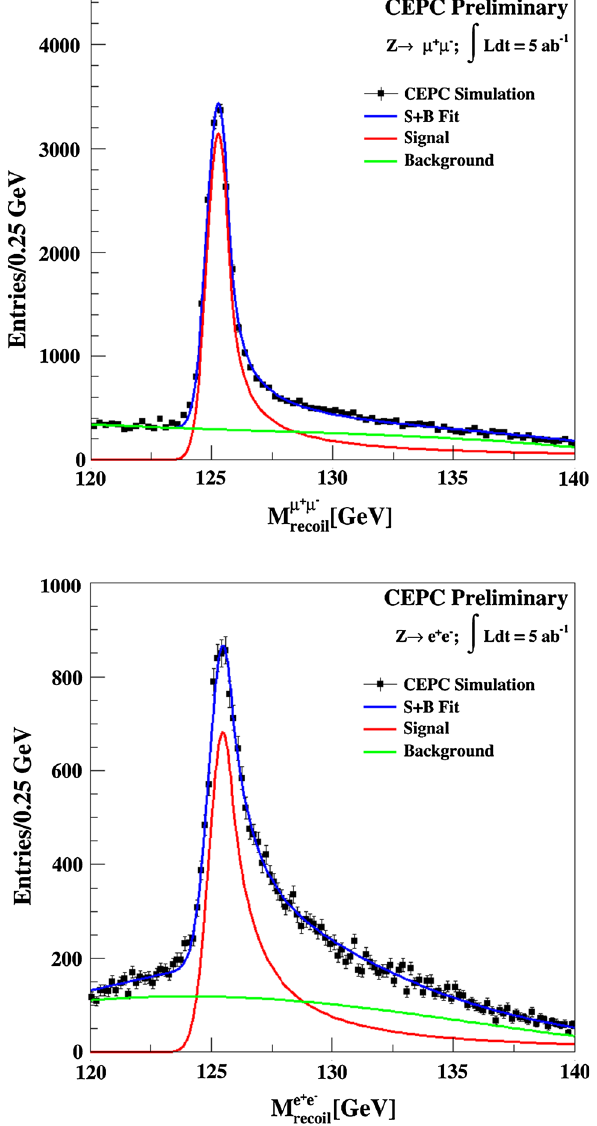
Fig. 9 The recoil mass spectrum of ee/ μμ , low energy peak in eeH corresponds to the Z fusion events